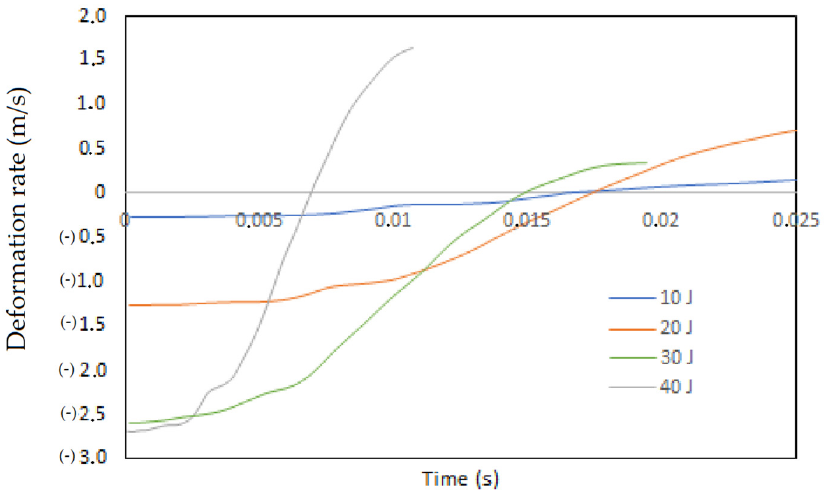
Figure 14. Analysis of the deformation speed (m/s) of the panels tested at 10, 20, 30 and 40 Joules.